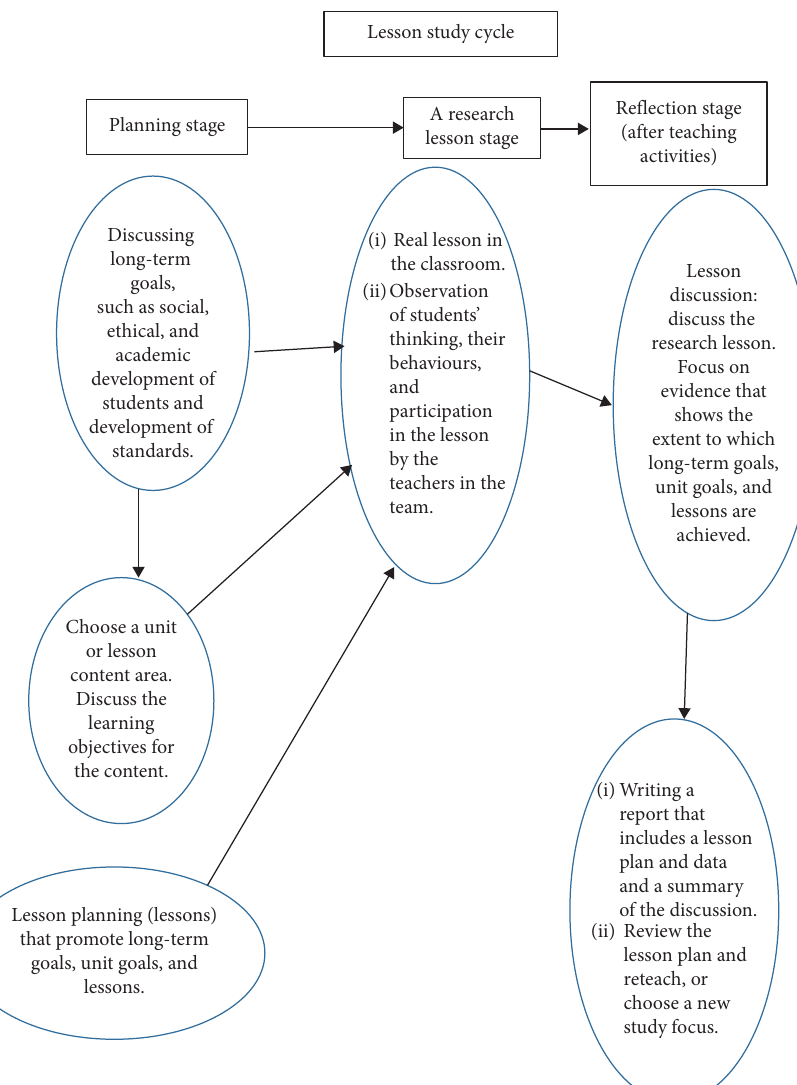
Figure 1: The stages of the lesson